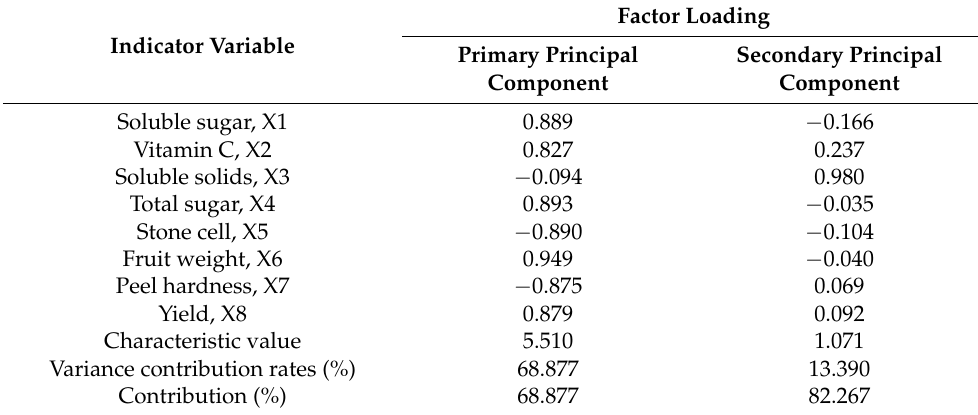
Table 8. Principal component analysis: factor load and variance contribution